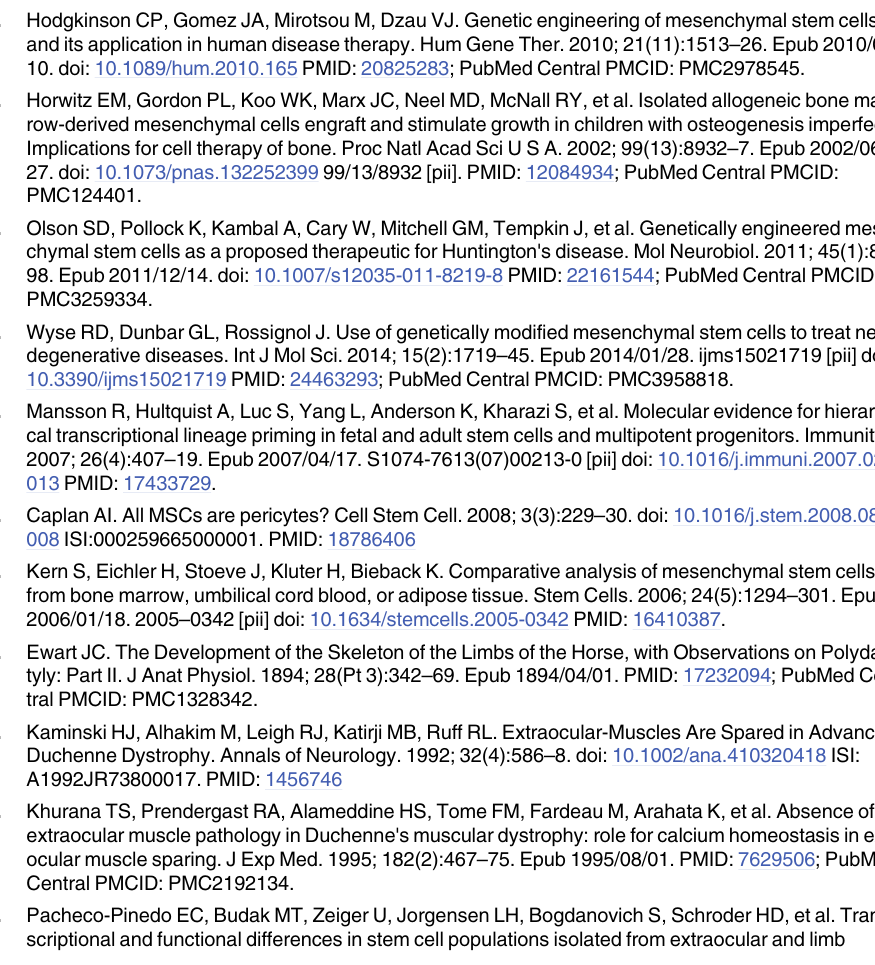
S3 Fig. Karyotype analysis of EOM-MSC. EOM-MSC showed normal number of chromo- somes (passage 10 –